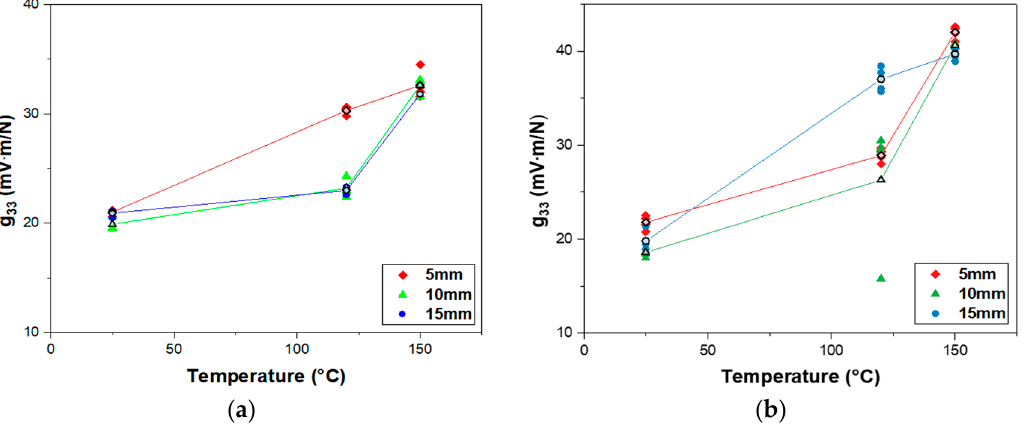
Figure 5. Piezoelectric voltage coefficient 𝑔 (cid:2871)(cid:2871) of poled PZT–PVB composites versus poling temper ‐ ature with various diameters of the electrodes: ( a ) alumina substrate; ( b ) mylar substrate. Since the variation in 𝑑 (cid:2871)(cid:2871) values for piezocomposites on the mylar substrate is larger than that on the alumina substrate and because the largest 𝑑 (cid:2871)(cid:2871) was obtained on mylar based samples poled at 150 °C, additional PZT–PVB samples were prepared under the same conditions. Figure 6 shows the distribution of 𝑑 (cid:2871)(cid:2871) values of the PZT–PVB compo ‐ sites poled at 150 °C on the mylar substrate. 𝑑 (cid:2871)(cid:2871) values were between 13.3 and 14.4 pC/N regardless of the diameter of the electrodes, meaning that the piezoelectric property of the composites poled at 150 °C was rather stable.